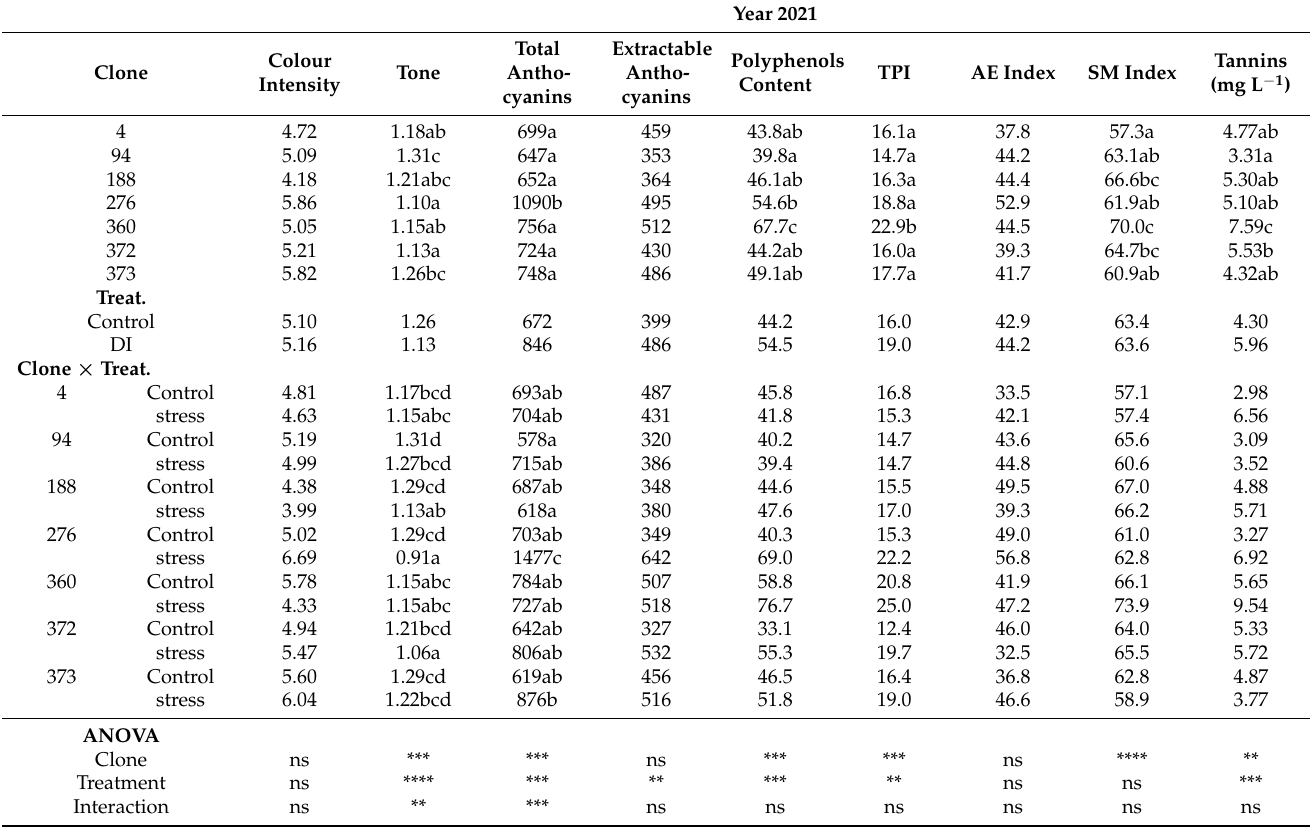
Table 11. Average annual values of berry phenolic quality at harvest for each clone, irrigation treatment, and the interaction (clone × irrigation treatment) during year 2021. Total